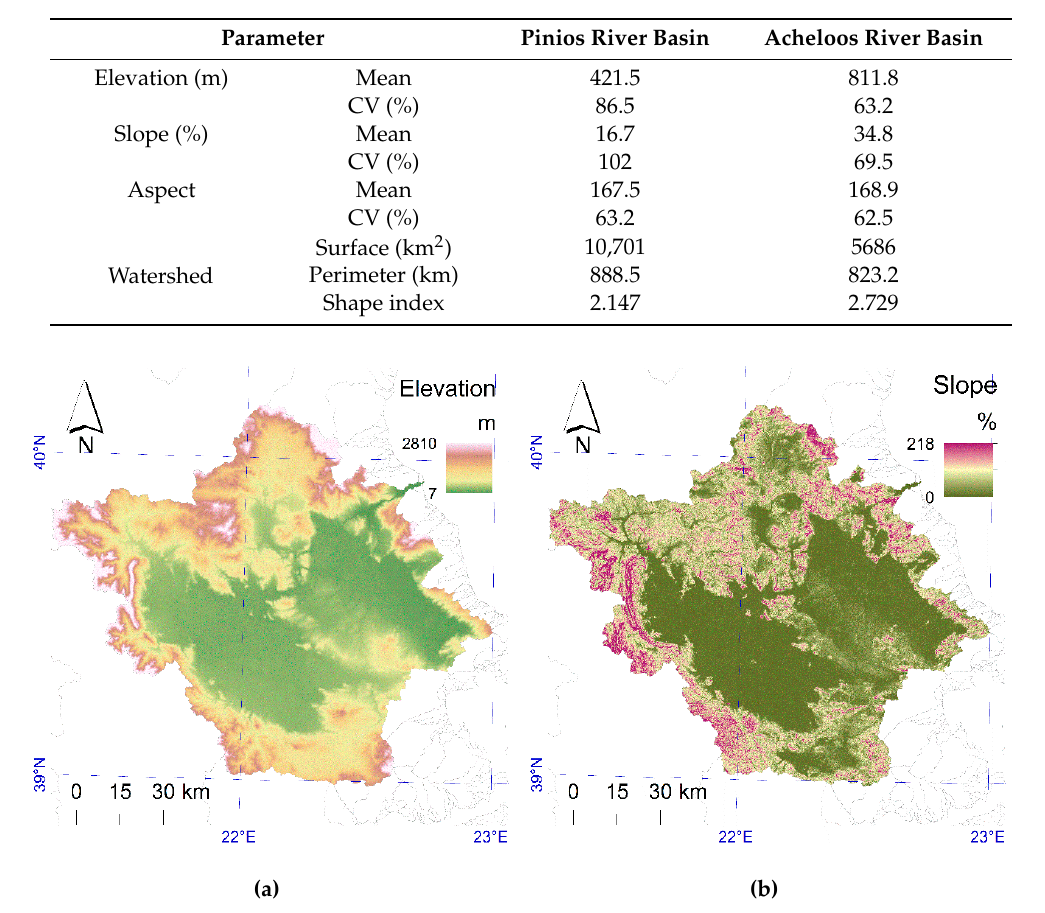
Table 2. Statistics, properties, and metrics of the main topographic and hydrographic features computed for the two experimental river basins.